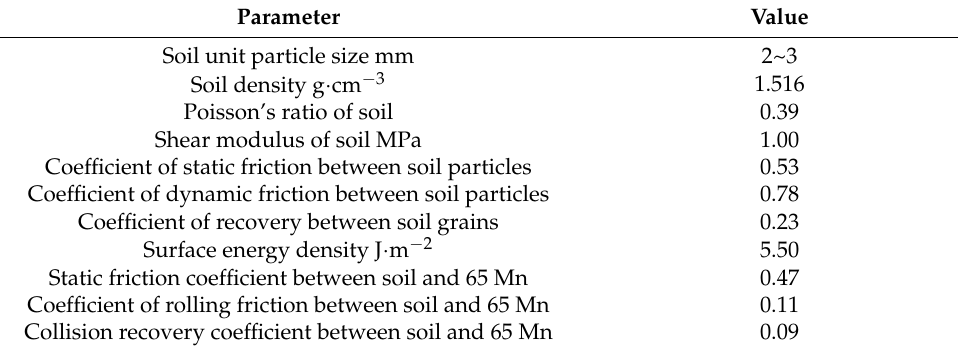
Table 1. Parameter list of DEM virtual simulation test model.